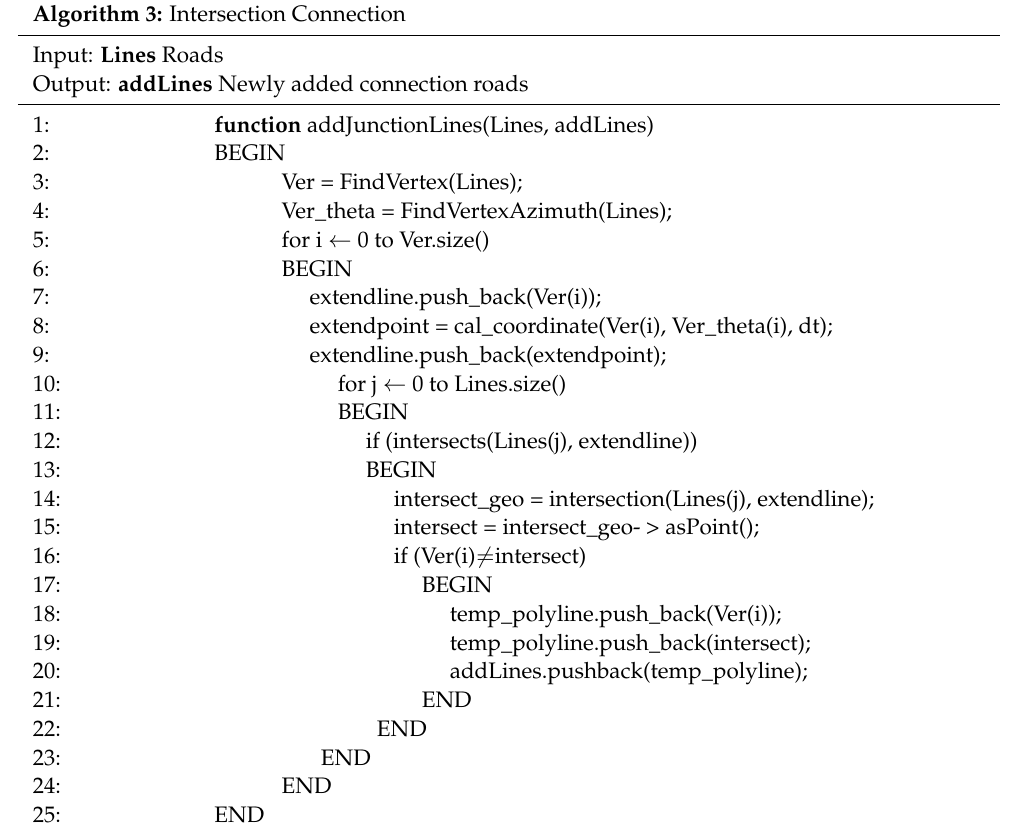
Figure 13. Intersection connection results: ( a , c , e ) depict the road intersections before the connection is performed and ( b , d , f ) are the results of the intersection connection algorithm.